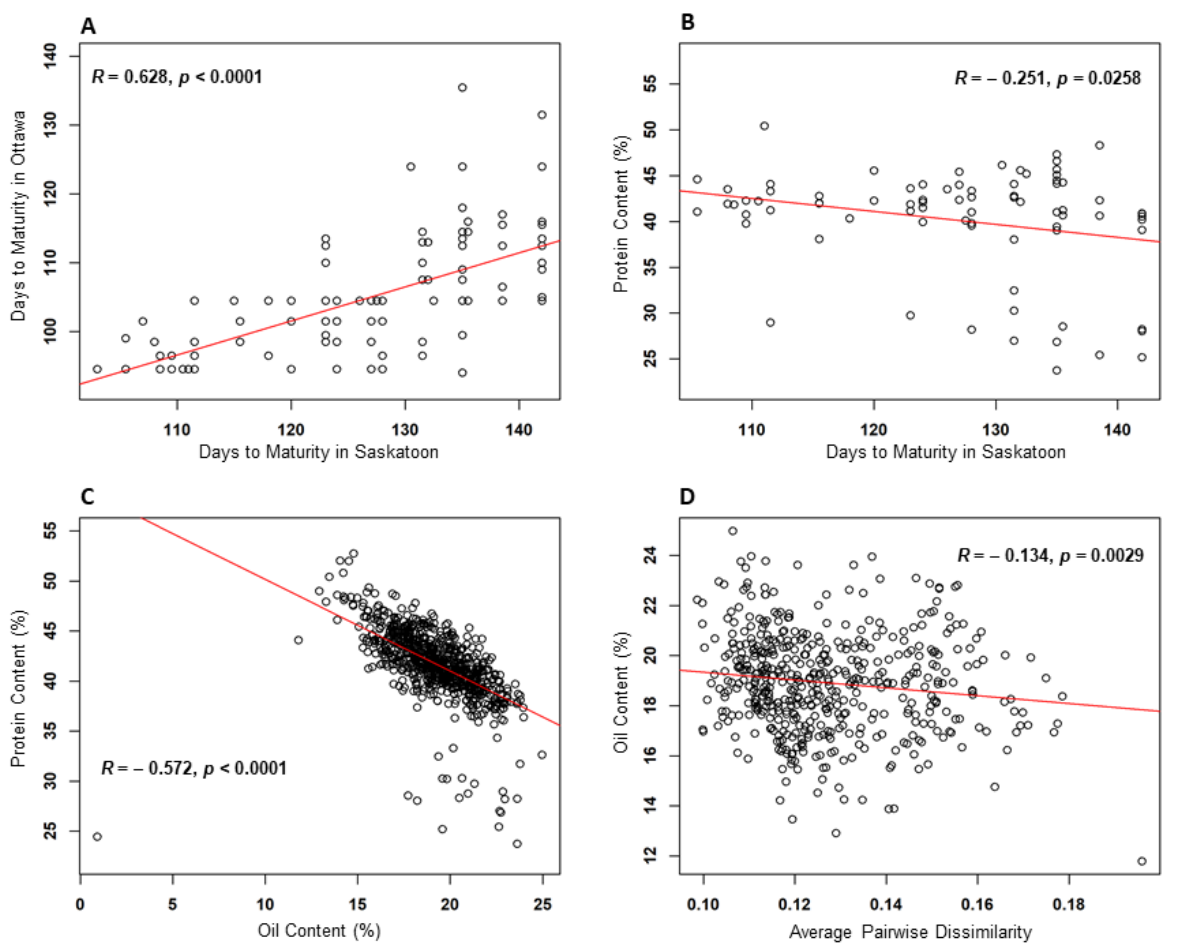
Figure 2. Four significant trait correlations detected among maturity, oil and protein concentration, and genetic distinctness of the assayed soybean